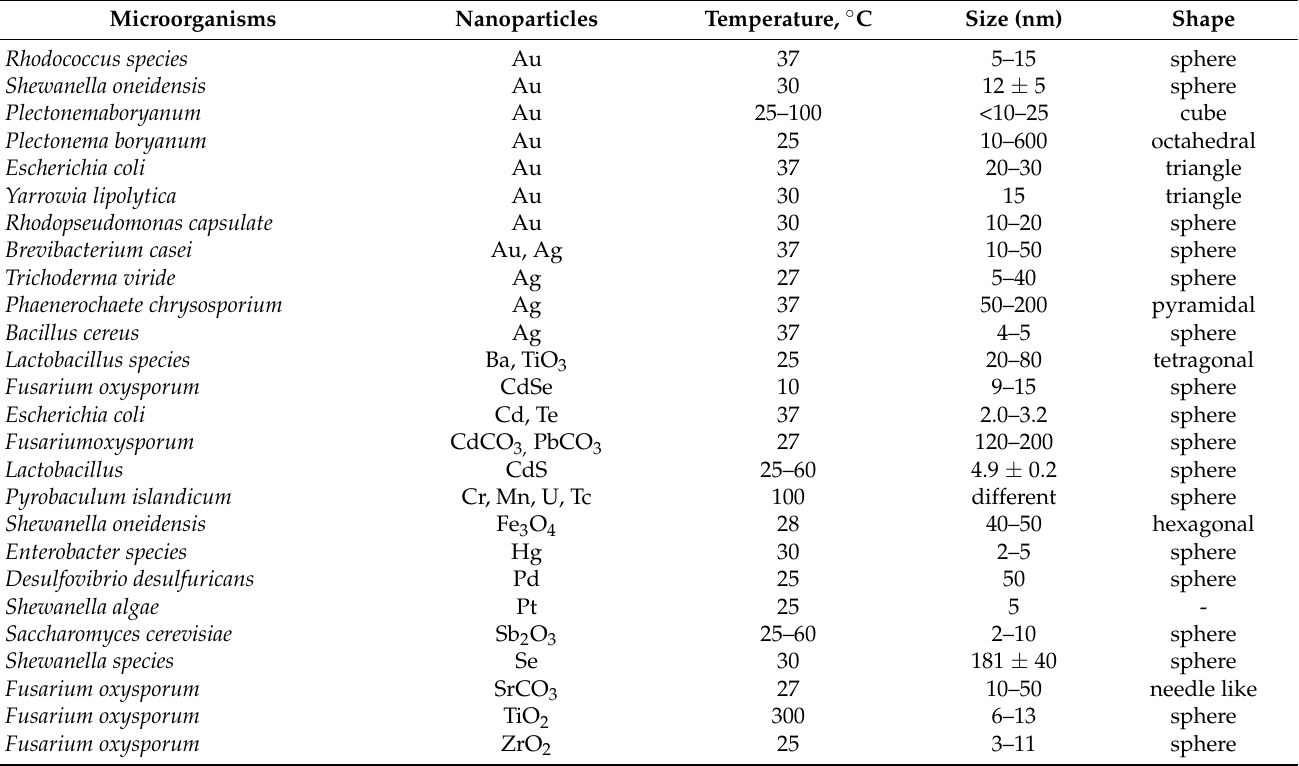
Table 5. Nanoparticles synthesized by microorganisms